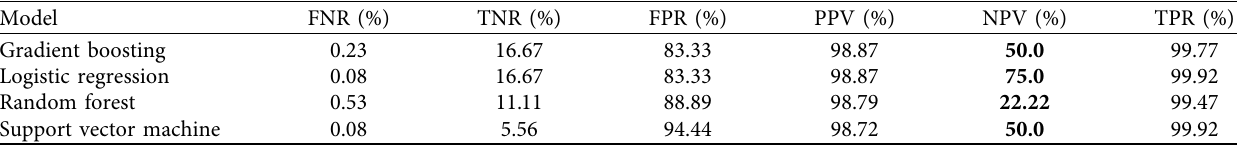
Table 1: Specifcity and sensitivity test scores.